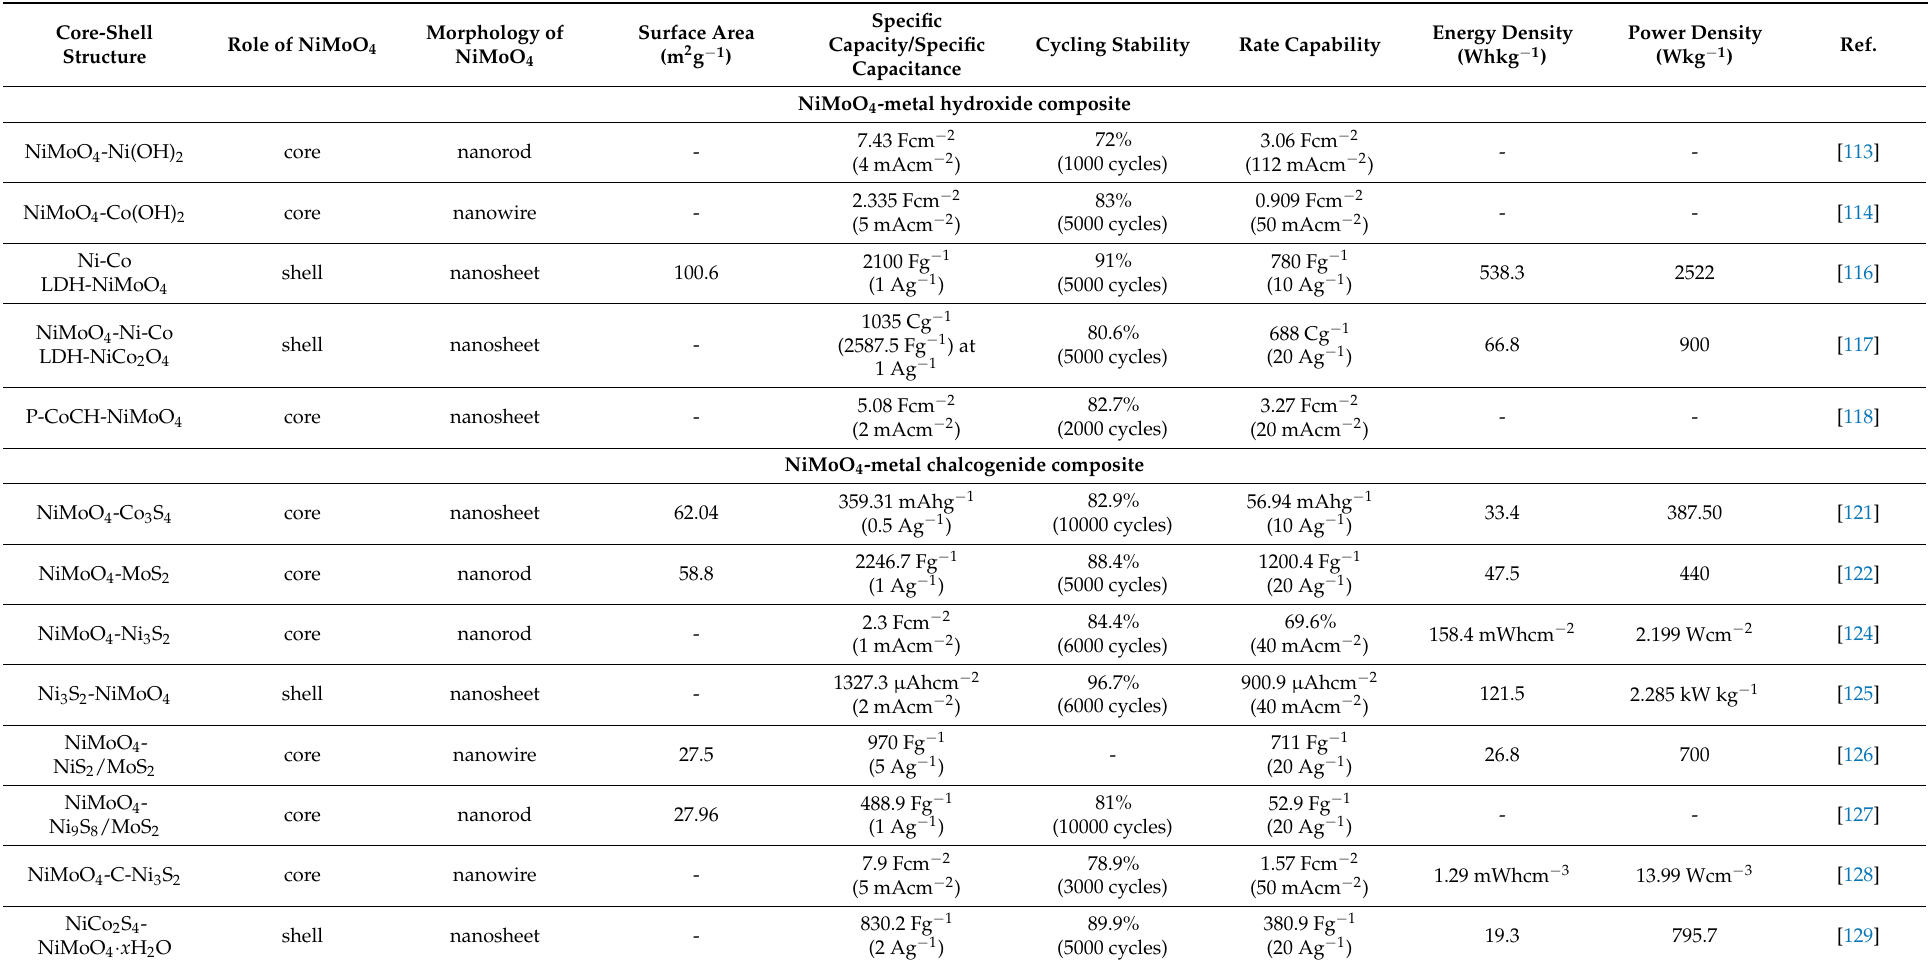
Table 2. Electrochemical performances of core-shell structures using composites of NiMoO 4 -metal hydroxide, NiMoO 4 -metal chalcogenide, NiMoO 4 -carbon material, NiMoO 4 -conductive polymer for